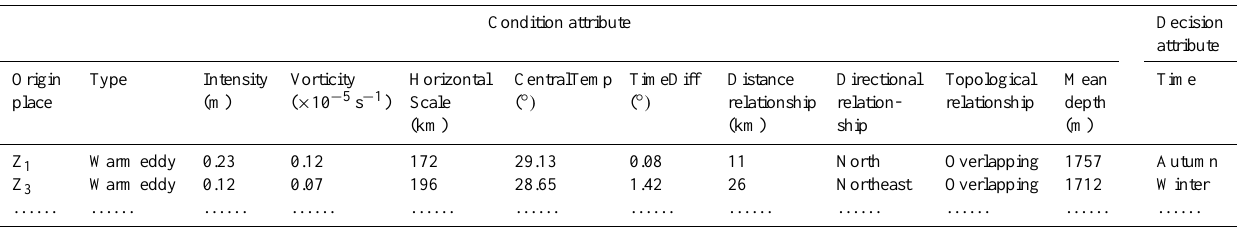
Table 3. Decision table constructed from spatial-temporal relationships of mesoscale-eddy states in 4 seasons.